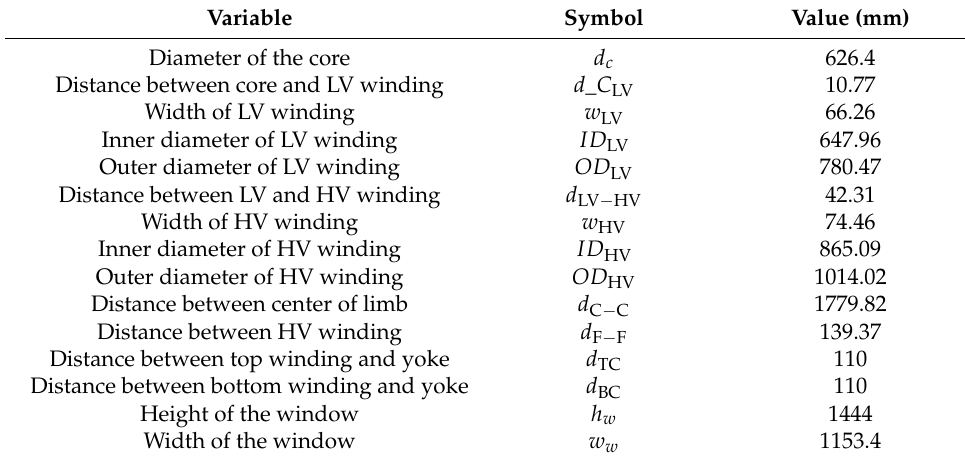
Figure 7. Dimension of the core and the winding in one window. Table 5. Dimension of the core and the